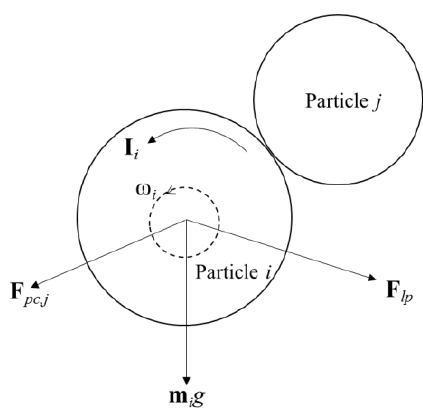
Figure 1. Schematic of collision forces between particles i and j.